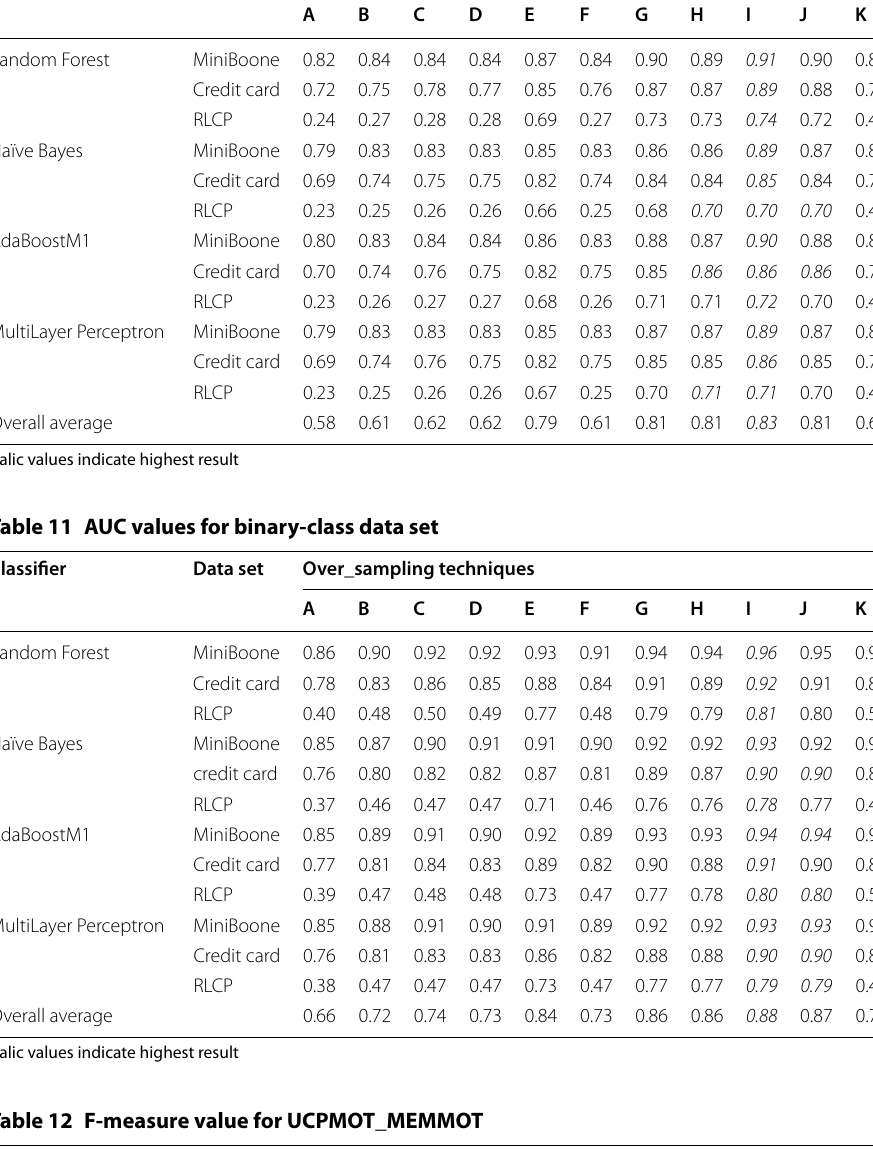
Table 10 F-measure values for binary-class data set